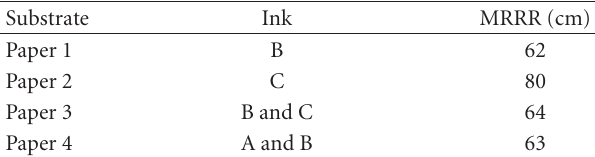
Table 6: The best MRRR values measured with circularly polarized reader